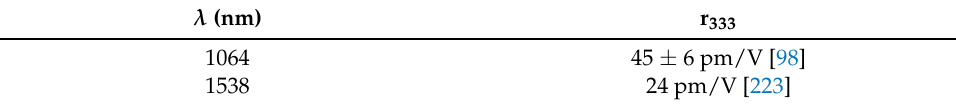
Table 24. Linear electro-optic coefficients of